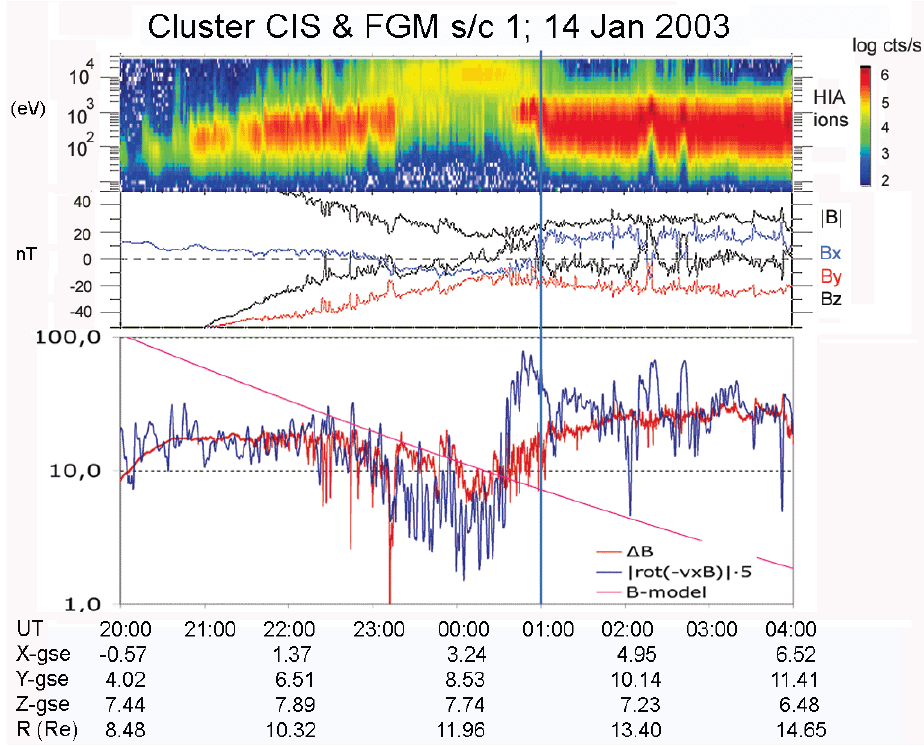
Fig. 7. Cluster s/c 1 CIS and FGM data on 14 January 2003 for “ideal MHD” testing. The format is the same as in Fig. 6 ( ρ =5). Vertical line marks the magnetopause traversal ( ≈ 01:00